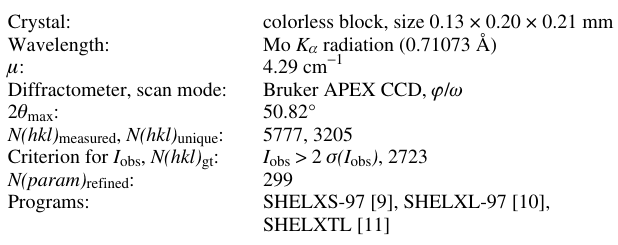
Table 1. Data collection and handling.